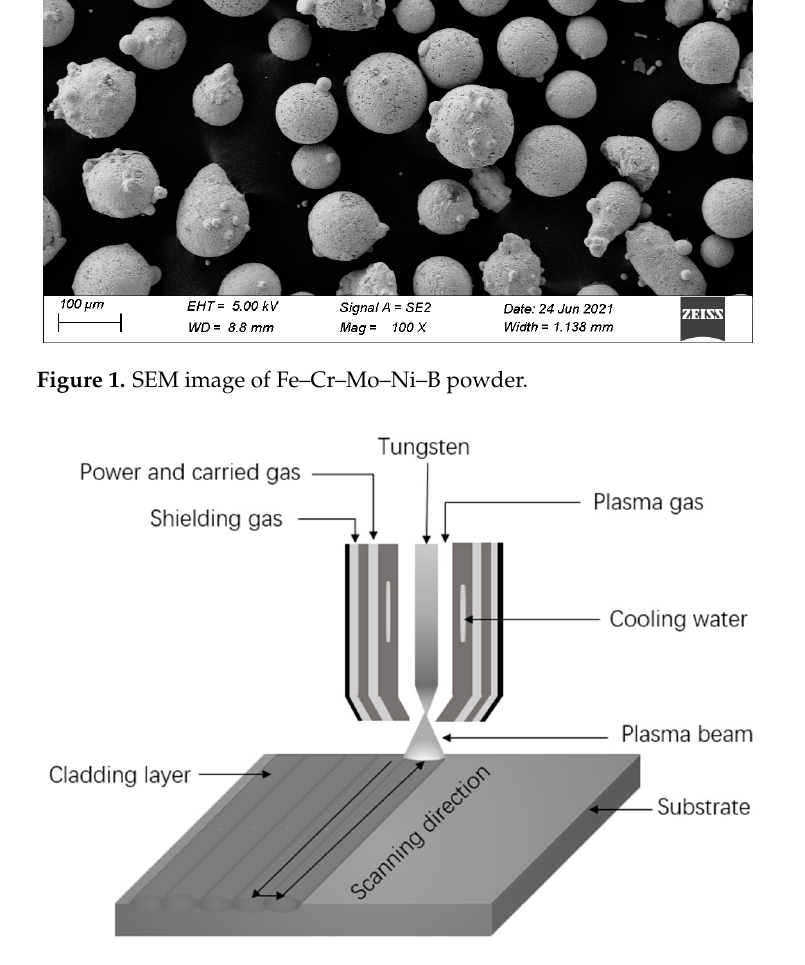
Figure 2. Schematic diagram of plasma cladding.